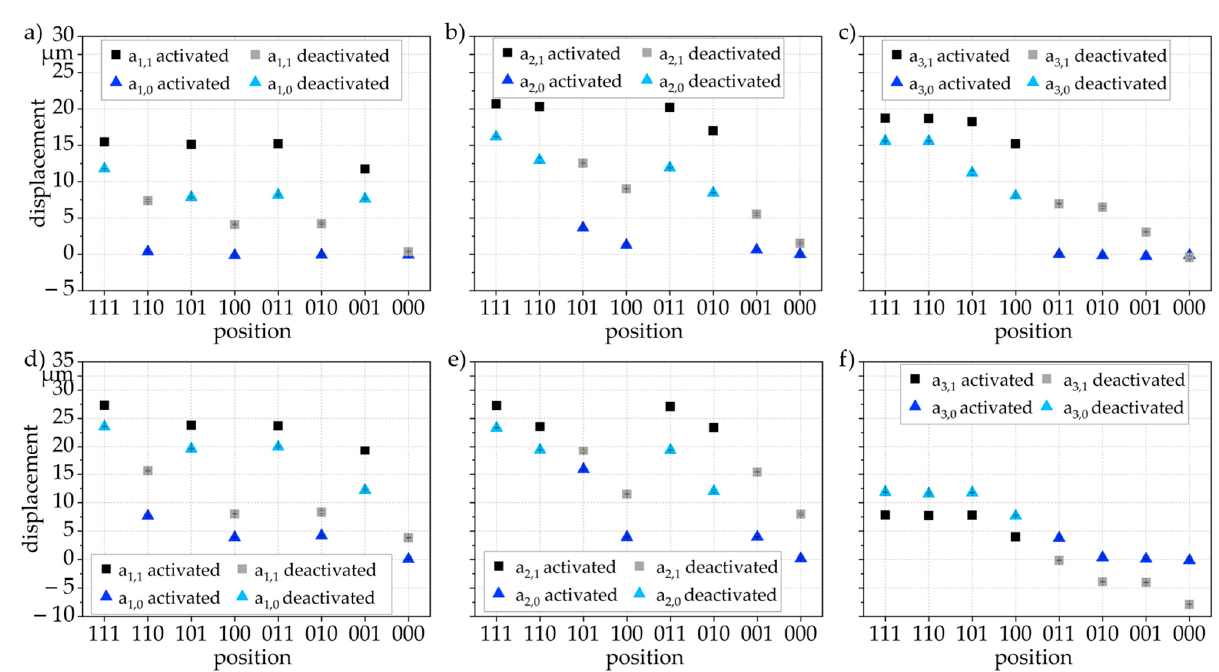
Figure 12. Experimental average actuator displacement of the single bits; each experiment was repeated three times. The experimental conditions correspond to the description in Figure 11. ( a ) Bit 1, ( b ) bit 2 and ( c ) bit 3 of system 1 at 60 V and ( d ) bit 1, ( e ) bit 2 and ( f ) bit 3 of system 2 at 75 V.